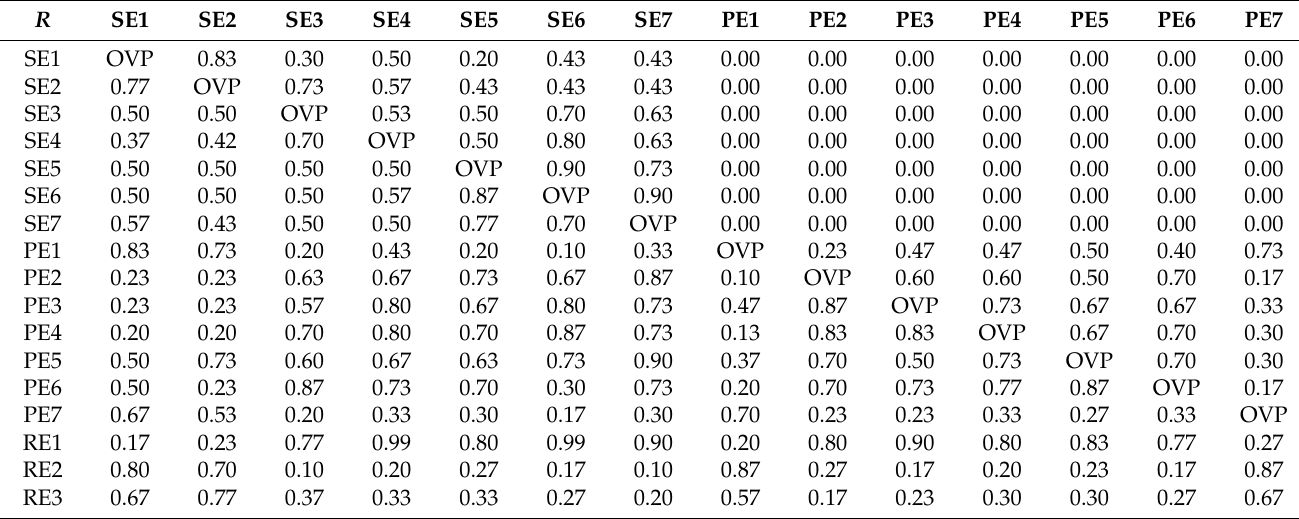
Table 7. Estimated conditional probability matrix R .